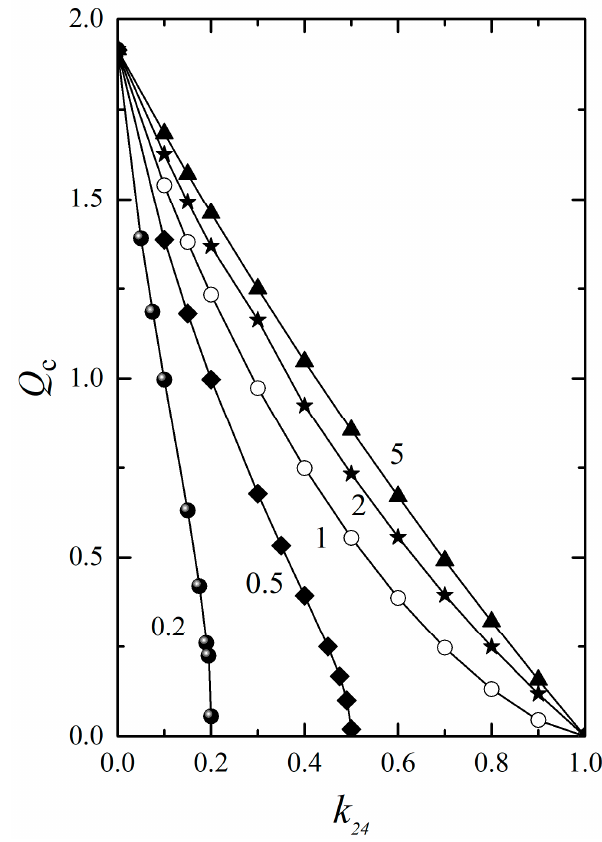
Figure 4. The dependence of the critical intrinsic chirality Q c (where Q 1 = 0) on k 24 in the case of zenithal anchoring for different values of anchoring strength. The results were calculated in points labelled with symbols and lines to serve as guides for the eye. From left to right: w = 0.2 (circles), 0.5 (diamonds), 1 (open circles), 2 (stars) and 5 (triangles).